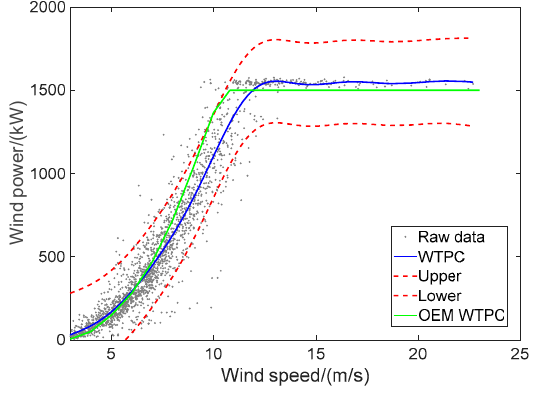
Figure 11. WTPC model via GPR.